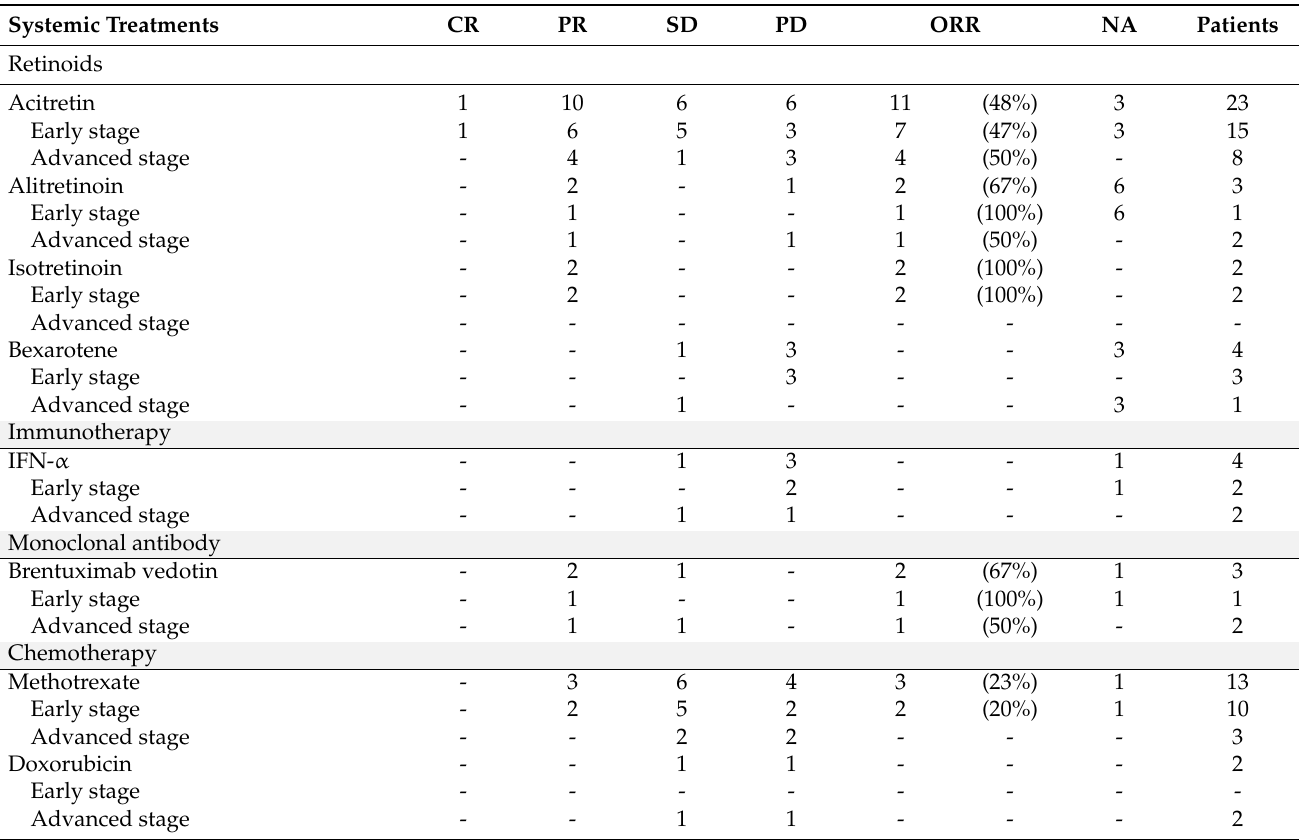
Table 5. Initial treatment outcomes for different systemic treatment modalities in those with early- stage disease and advanced-stage disease at the time of